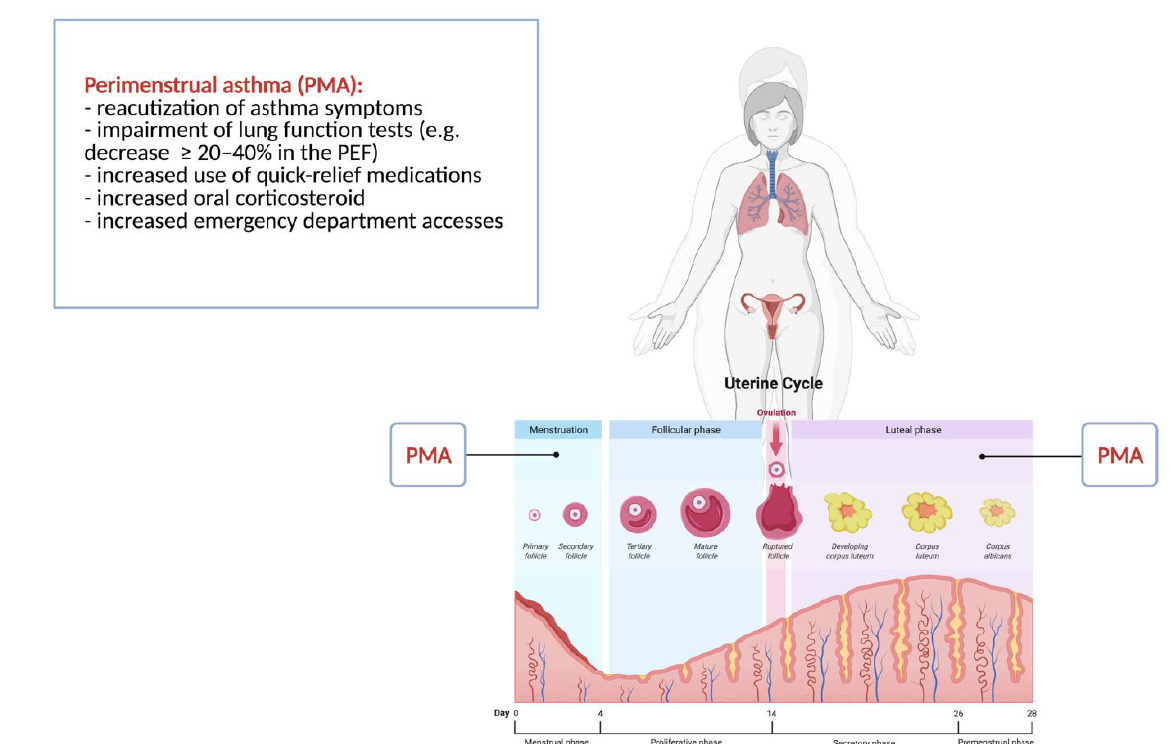
Figure 3. Perimenstrual asthma in young female adolescents.